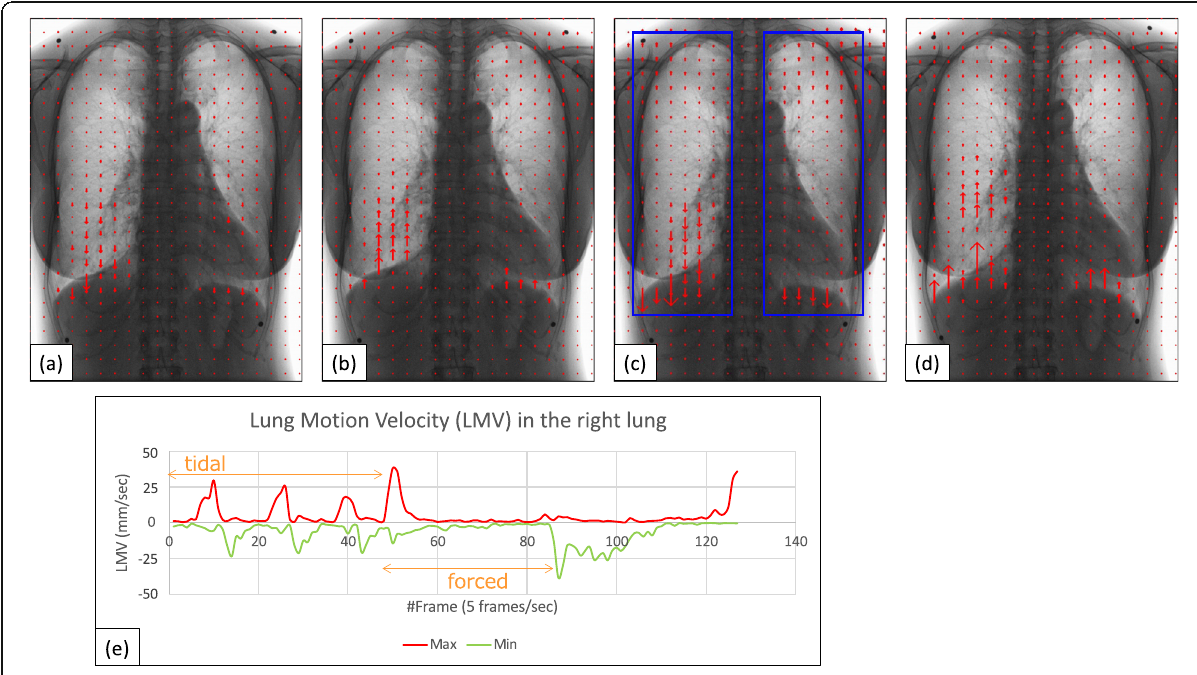
Fig. 2 A 58-year-old male healthy volunteer with FEV 1 % 73.3 and %FEV 1 92.4, included in the normal group. VF-DXR images: ( a ) tidal inspiratory, ( b ) tidal expiratory, ( c ) forced inspiratory, and ( d ) forced expiratory phases. Blue rectangles in Fig. 1c represent ROIs in both lungs. The graph ( e ) shows the temporal change between LMV in the right lung and the number of frames. The frame rate is set to 5 frames/s (Video 1, Supplemental material). FEV 1 % Forced expiratory volume percent in one second divided by forced vital capacity, %FEV 1 Percent predicted forced expiratory volume in one second, LMV Lung motion velocity, VF-DXR Vector-field dynamic x-ray, ROI Region of interest